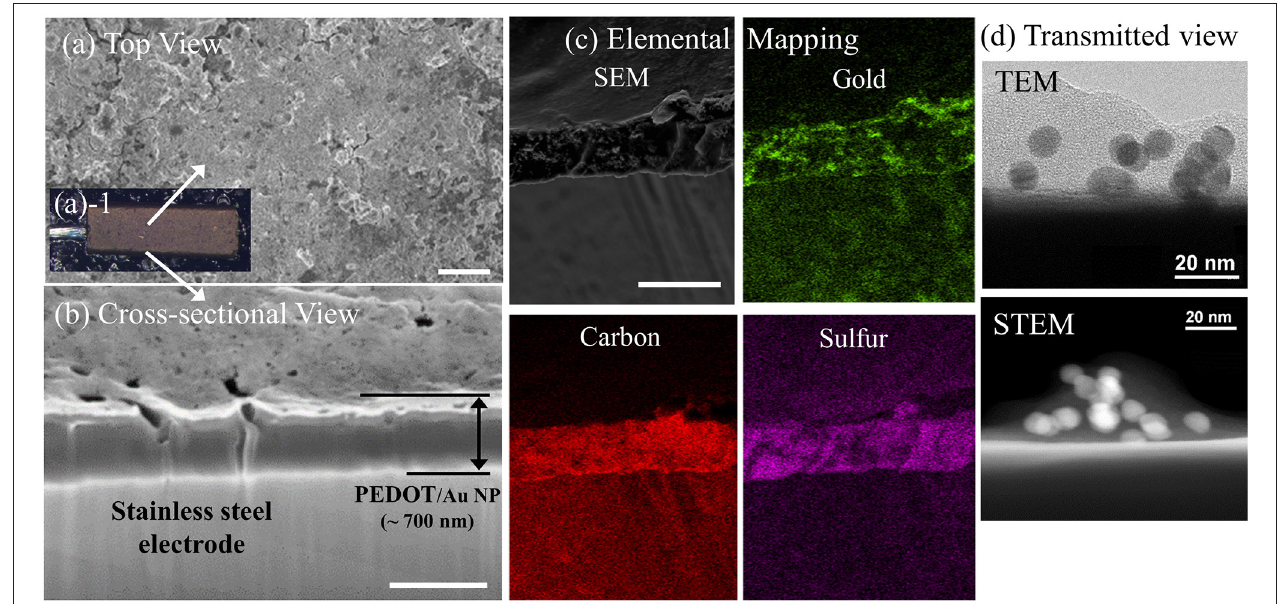
FIGURE 2 | Images of PEDOT/Au NP composites on a free-standing pad electrode. (a) Top view, (a-1) (a) SEM (scale bar 1 µ m) (b) optical microscopy (c) cross-sectional SEM images of PEDOT/Au NP composite and aggregated Au NPs on a pad electrode (scale bar 500nm) (d) Transmitted images of a PEDOT/Au NP composite by TEM and STEM.